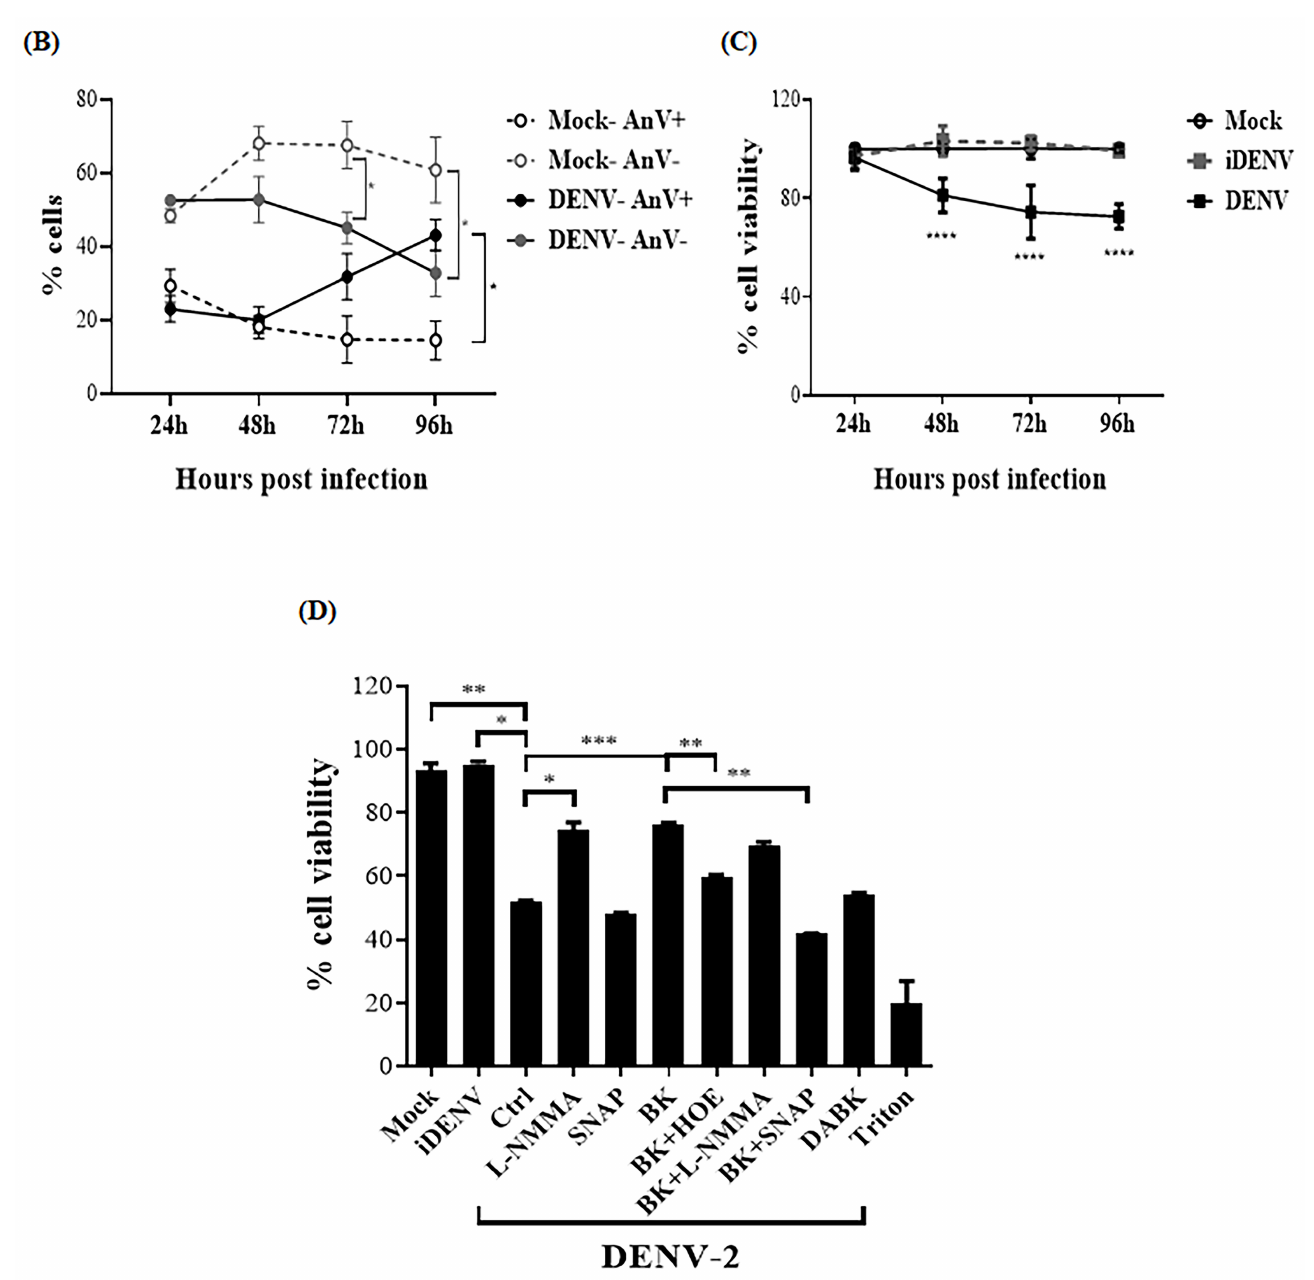
Figure 4. B2R activation and NO inhibition promotes a delay in DENV-induced cell death. ( A , B ) HBMECs were mock-treated or infected with DENV and, after different time points, the cells were stained with Alexafluor488-conjugated annexin V and propidium iodide (PI) and the frequency of apoptotic cells (% AnV+) was analyzed by flow cytometry. A representative dot blot is indicated in ( A ) and the average frequency of AnV+ and AnV- cells obtained in two independent experiments in indicated in ( B ). ( C ) HBMECs were mock-treated or cultured with DENV-2 in its native or inactivated forms (iDENV) and cell viability was evaluated by XTT metabolization assay at the indicated time points. ( D ) HBMECs were mock-treated or cultured with DENV-2 or iDENV for 24h and then, the cells were treated with BK or L-NMMA, in the presence or absence of HOE-140 or SNAP. At 72 h.p.i., cell viability was accessed by XTT metabolization assay. The data were normalized according to the results obtained with the cells cultured with culture medium only (adjusted to 100%). The data are representative of four independent experiments and error bars indicates SD values between replicates in all experiments. * represents p ≤ 0.05; ** p ≤ 0.01; *** p ≤ 0.001; **** p ≤